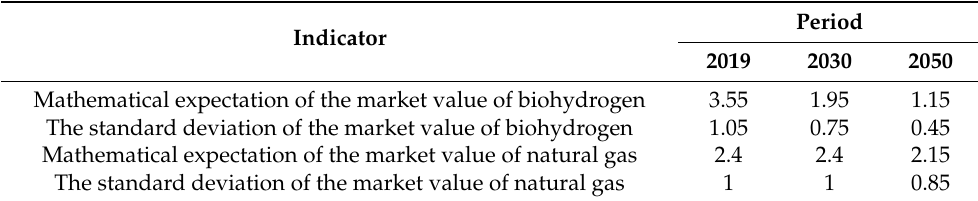
Period 2019 2030 2050